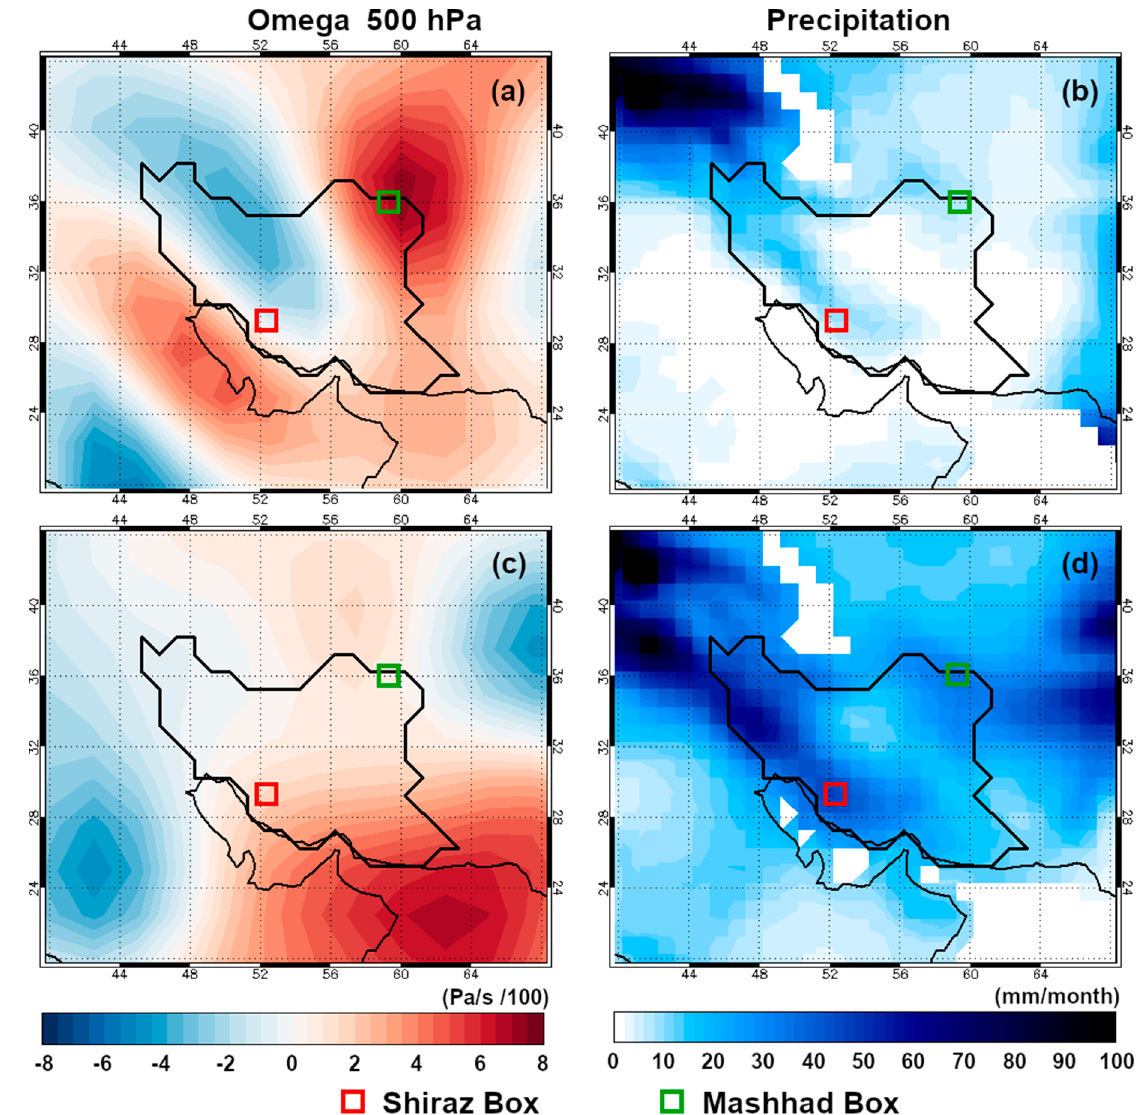
Figure 5. The stability of atmosphere (Omega ω ) variations ( a , c ) and precipitation amount distribution ( b,d ) over Iran and nearby regions for the dry and wet periods, respectively (1981–2014).